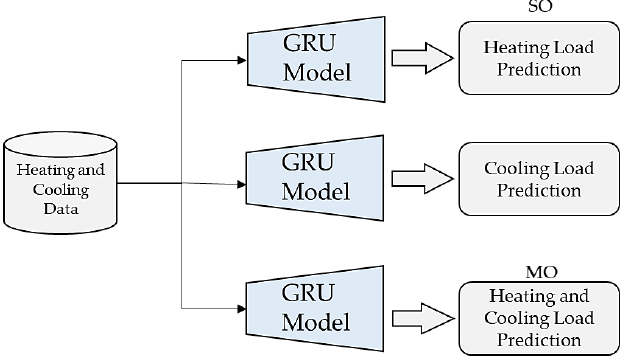
Figure 4. Difference between SO and MO in the prediction of HL and CL using the GRU model. Figure 4. Di ff erence between SO and MO in the prediction of HL and CL using the GRU